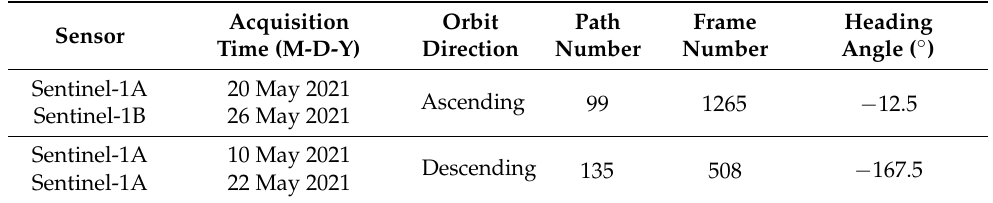
Table 1. Detailed information of SAR